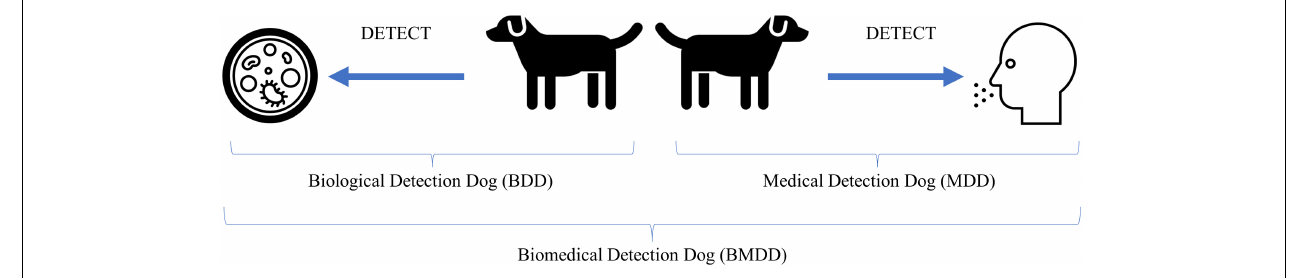
FIGURE 1 | Illustration of biological and medical detection dogs and what they detect. The Biological Detection Dog (BDD) detects the odor of (or odors associated with) the pathogen or etiological agent, while the Medical Detection Dog (MDD) detects the odor of (or odors associated with) the disease state produced by an infected host in response to the pathogen or the altered volatilome due to disease not caused by an infectious agent. Together, BDDs and MDDs can be categorized as Biomedical Detection Dog